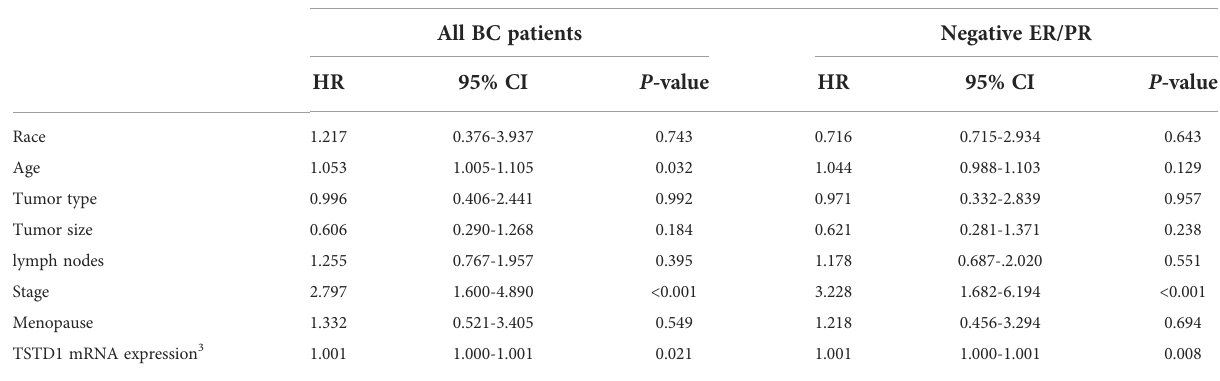
TABLE 3 Cox proportional hazard model of clinical parameters and TSTD1 mRNA expression level in TCGA breast